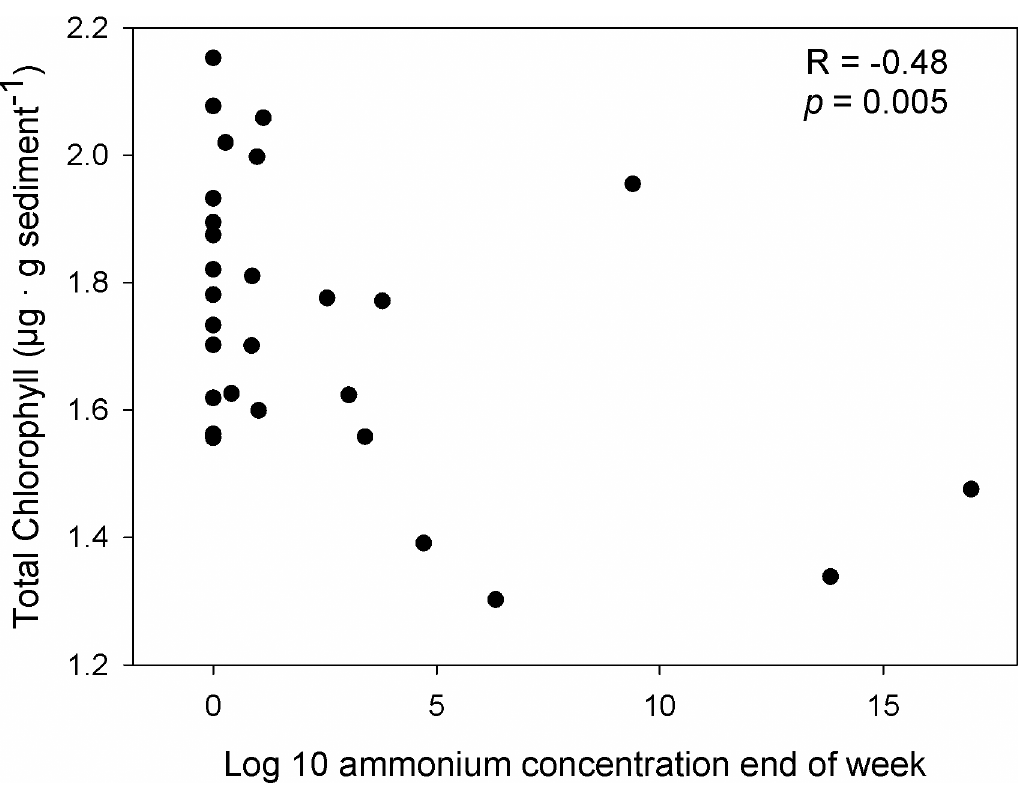
Fig 5. Relationship between ammonium concentration in the water and biomass of benthic microalgae at the end of each week. Only data of treatments without Ulva sp. and with ammonium addition were used for this analysis (n =